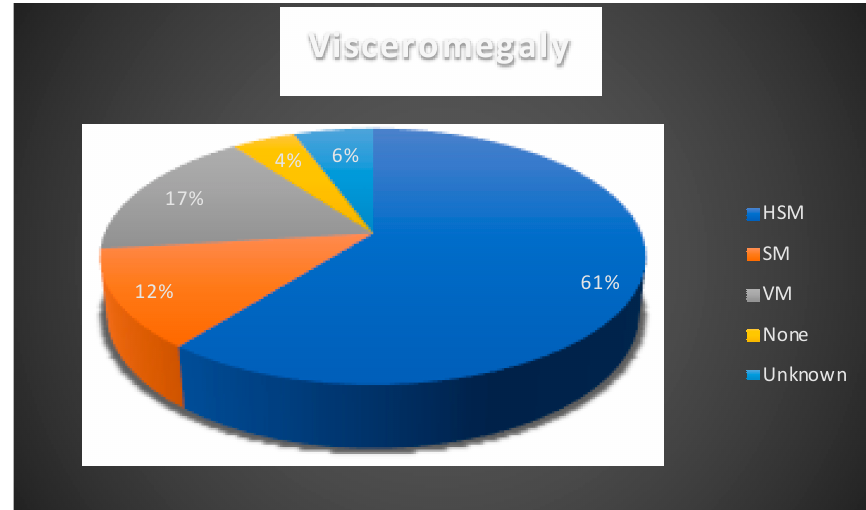
Figure 2. Presence of visceromegaly reported in NPC1 cases. HSM: hepatosplenomegaly, VM: visceromegaly, SM: splenomegaly. Blue: hepatomegaly; orange: splenomegaly; grey: visceromegaly; yellow: none; light blue: unknown